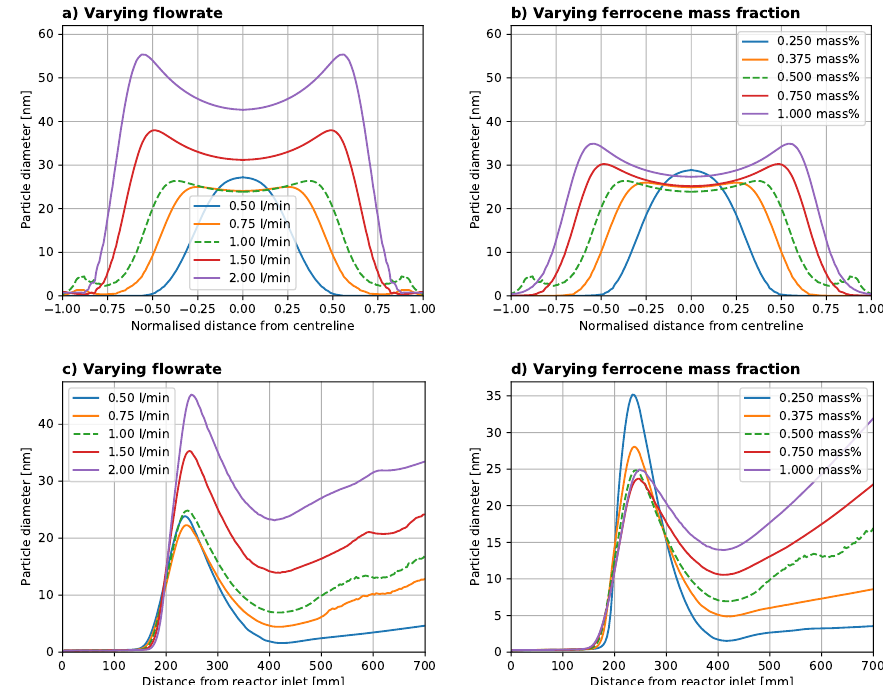
Figure 6. Average particle diameter in the reactor: ( a , b ) the radial particle diameter profile, 500mm downstream from the inlet; ( c , d ) the axial profile, averaged over the reactor radius; ( a , c ) the variations with flowrate (at 1250 ◦ C peak temperature and 0.5mass% ferrocene); and ( b , d ) the variations with input iron mass (at 1lmin − 1 and 1250 ◦ C peak temperature).